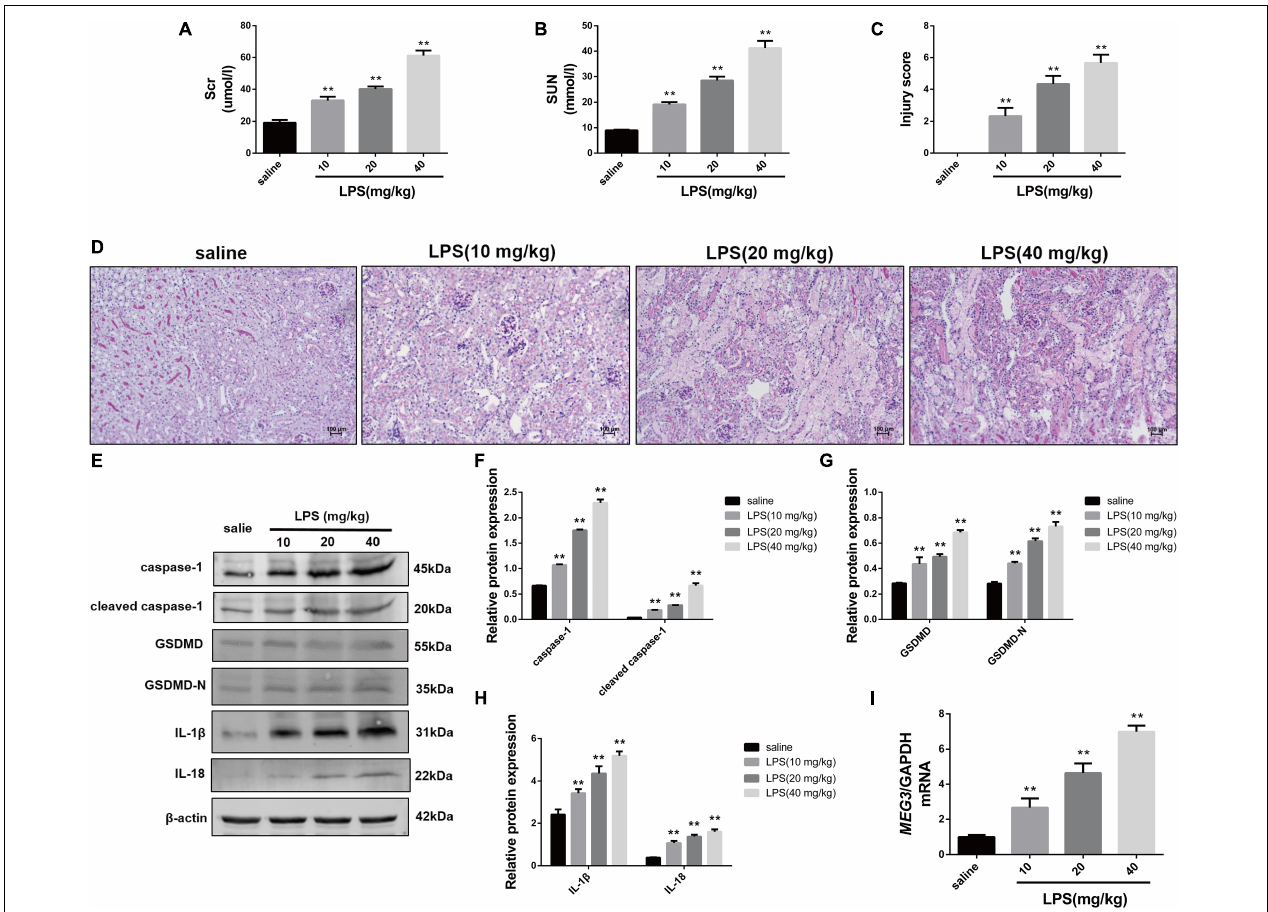
FIGURE 1 | Increased expression of pyroptosis-associated proteins and MEG3 in kidneys of mice with LPS-induced AKI ( n = 6). (A) Serum creatinine level in mice with LPS-induced AKI and control saline-treated mice. (B) Serum urea nitrogen levels in mice with LPS-induced AKI and control saline-treated mice. (C) PAS staining of mouse kidneys (200 × ). (D) Score of renal tubular injury in mice. (E–H) Expression of caspase-1, cleaved caspase-1, GSDMD, GSDMD-N, IL-1 β , and IL-18 in renal tissues of mice. (I) Expression level of MEG3 mRNA in mouse kidney tissue. ** P < 0.01, compared with normal saline-treated group; all values are expressed as mean ± standard deviation